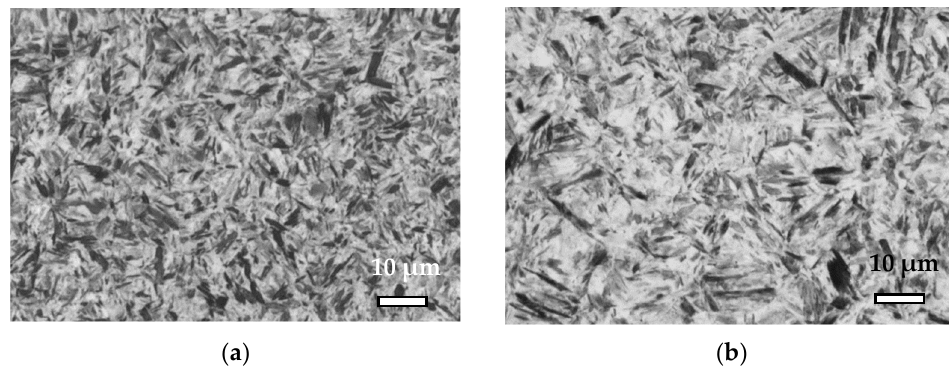
Figure 6. ( a ) Microstructure of 42C steel for cooling rate of 50 °C/s; ( b ) microstructure of 42D steel for cooling rate of 50 °C/s.